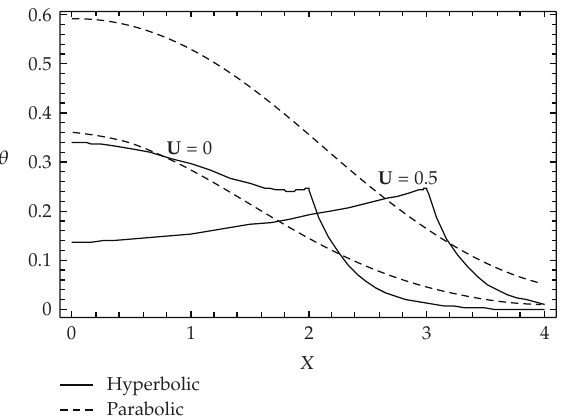
Figure 4: Dimensionless temperature distributions resulting from the hyperbolic and parabolic models with dimensionless velocity of the medium for the instantaneous heat source; φ (cid:3) η (cid:4) (cid:5) δ (cid:3) η (cid:4) , ψ 3 , and η (cid:5) 2